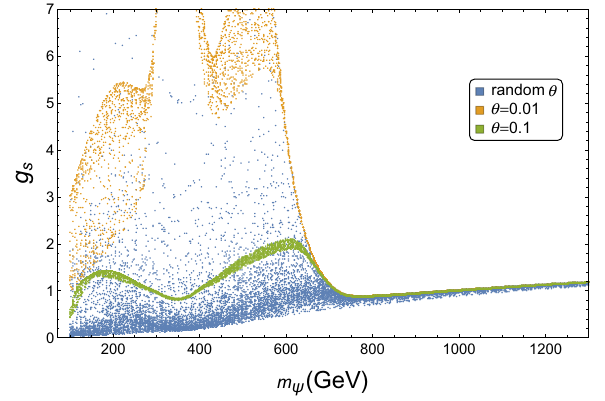
Fig. 2 The coupling g s in terms of the dark matter mass m ψ for three different types of choice of the mixing angle θ